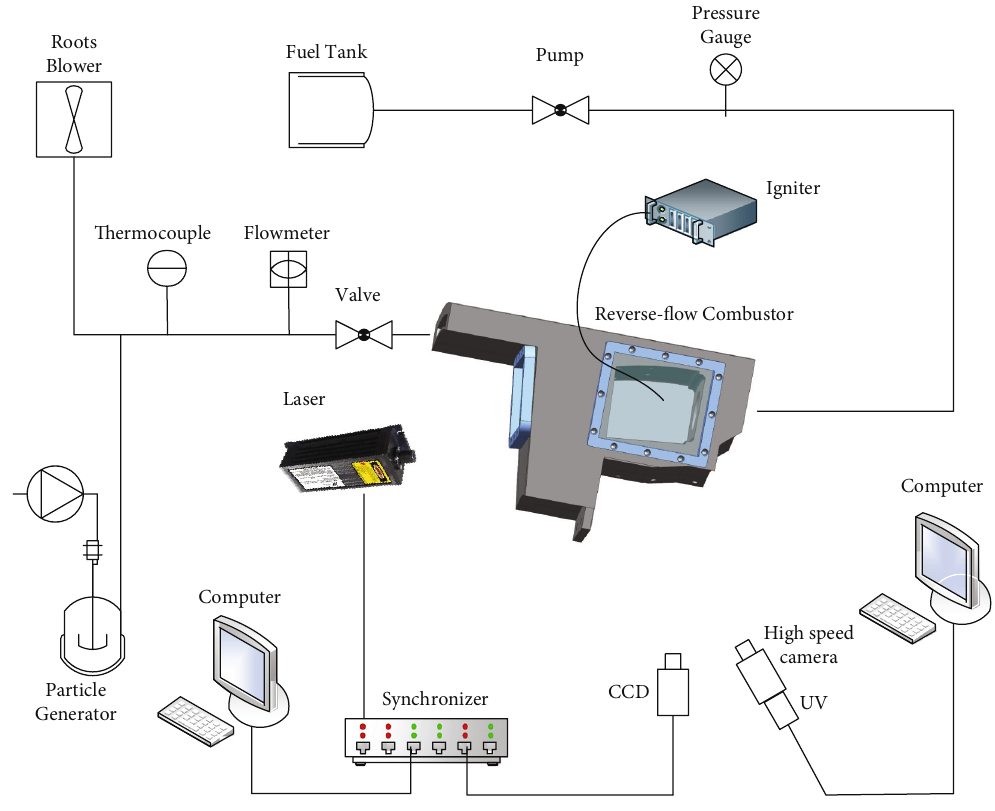
Figure 2: Schematic of the experiment Table 2: Parameters of the experiment.